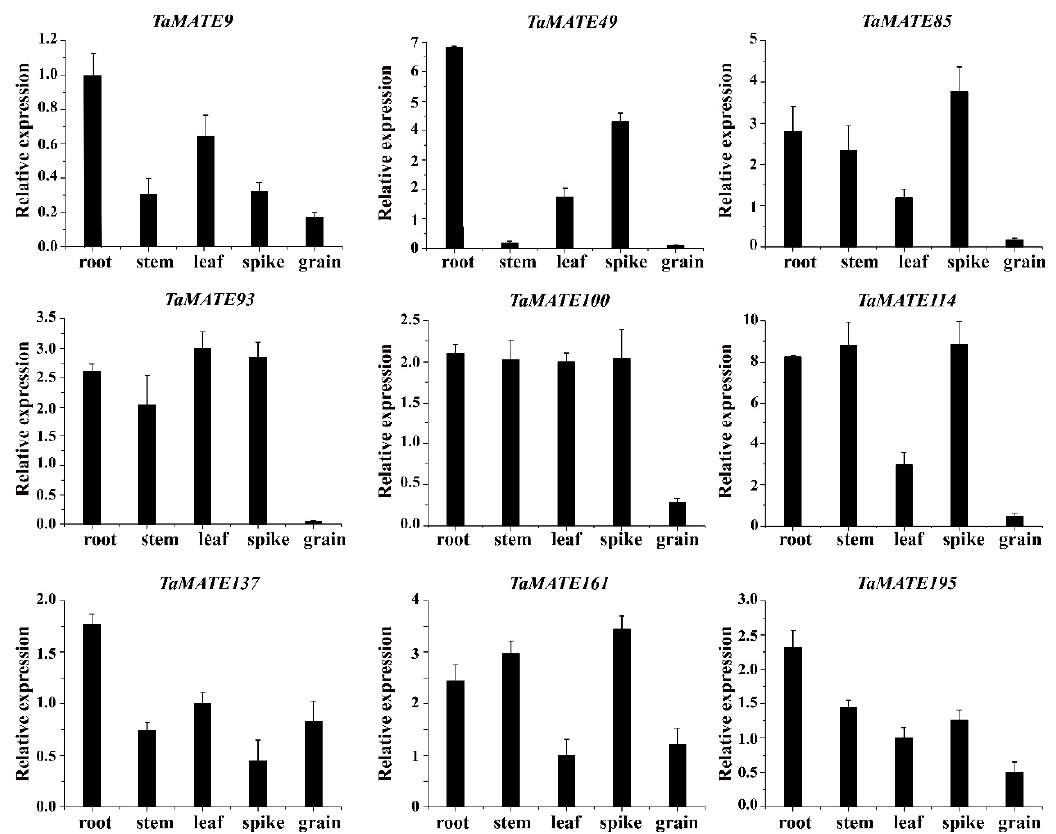
Figure 6. qRT-PCR expression analysis of 9 TaMATE genes in root, stem, leaf, spike and grain from Zhongmai 175. Nine TaMATE genes included TaMATE9 , TaMATE49 , TaMATE85 , TaMATE93 , TaMATE100 , TaMATE114 , TaMATE137, TaMATE161 and TaMATE195 . Error bar represents Sd.